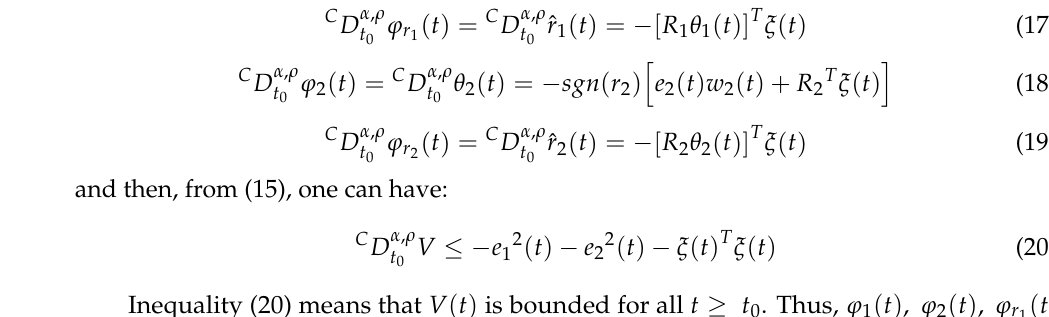
(cid:104) (cid:105) T 1 e − t 2